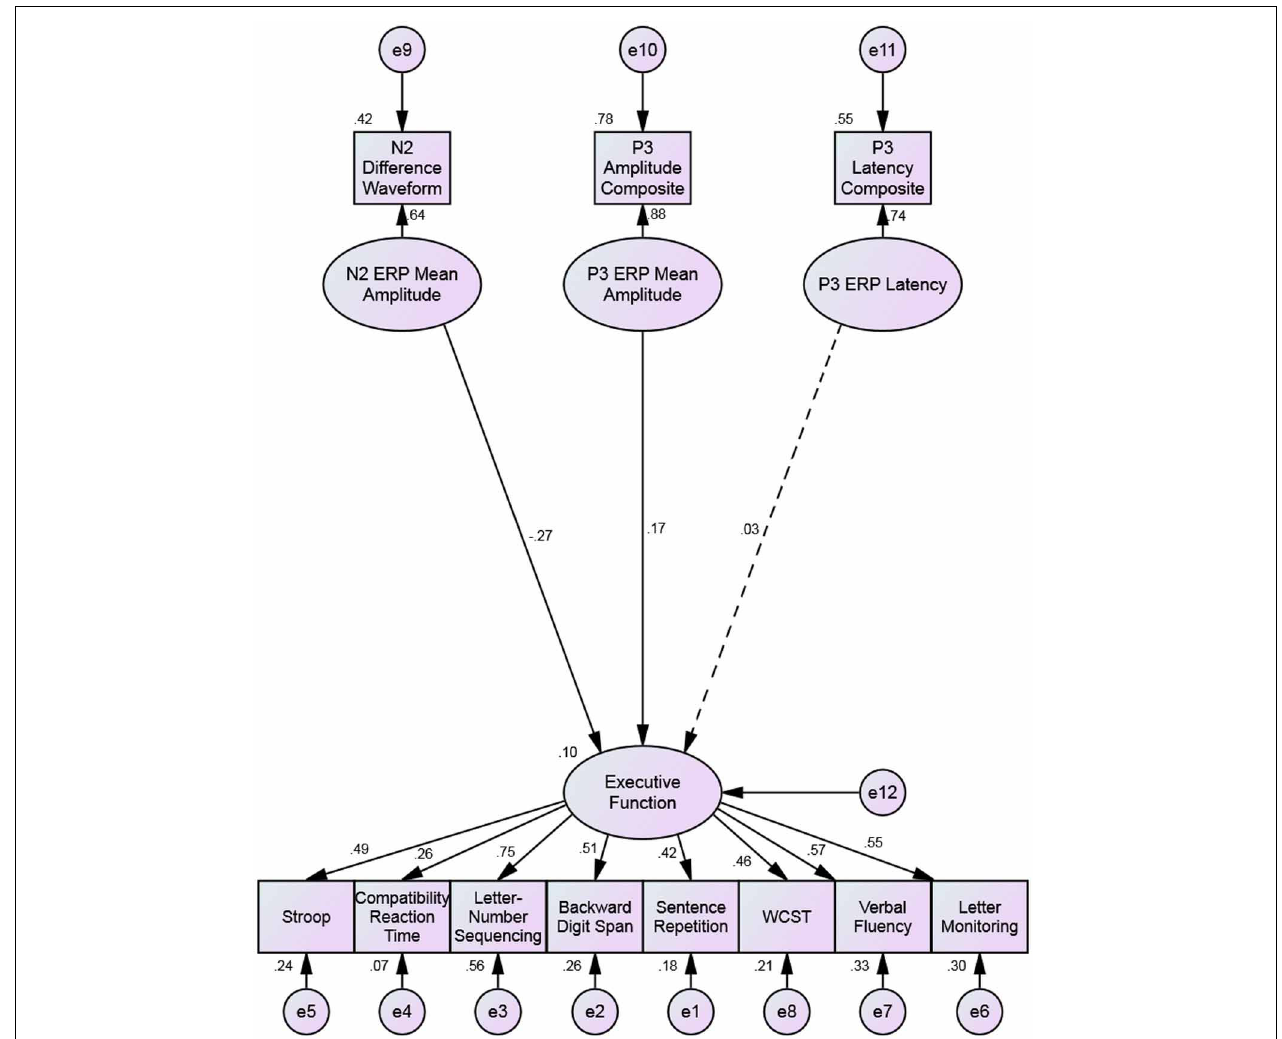
FIGURE 3 | Structural equation model predicting executive functioning with the N2 amplitude, P3b amplitude, and P3b latency. Single-headed arrows have standardized factor loadings next